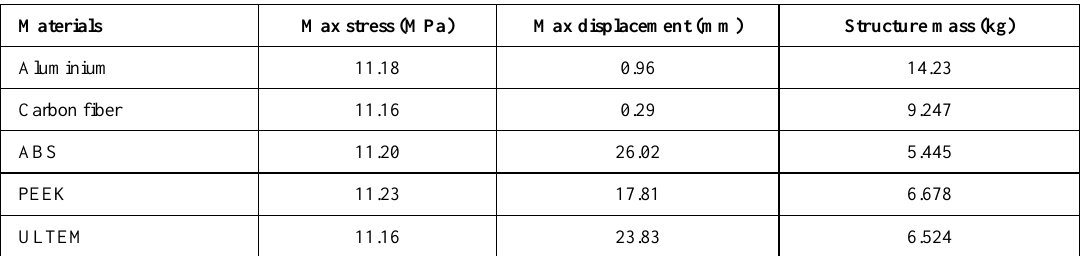
Table 1. Structural analysis results of various materials for UAV frame